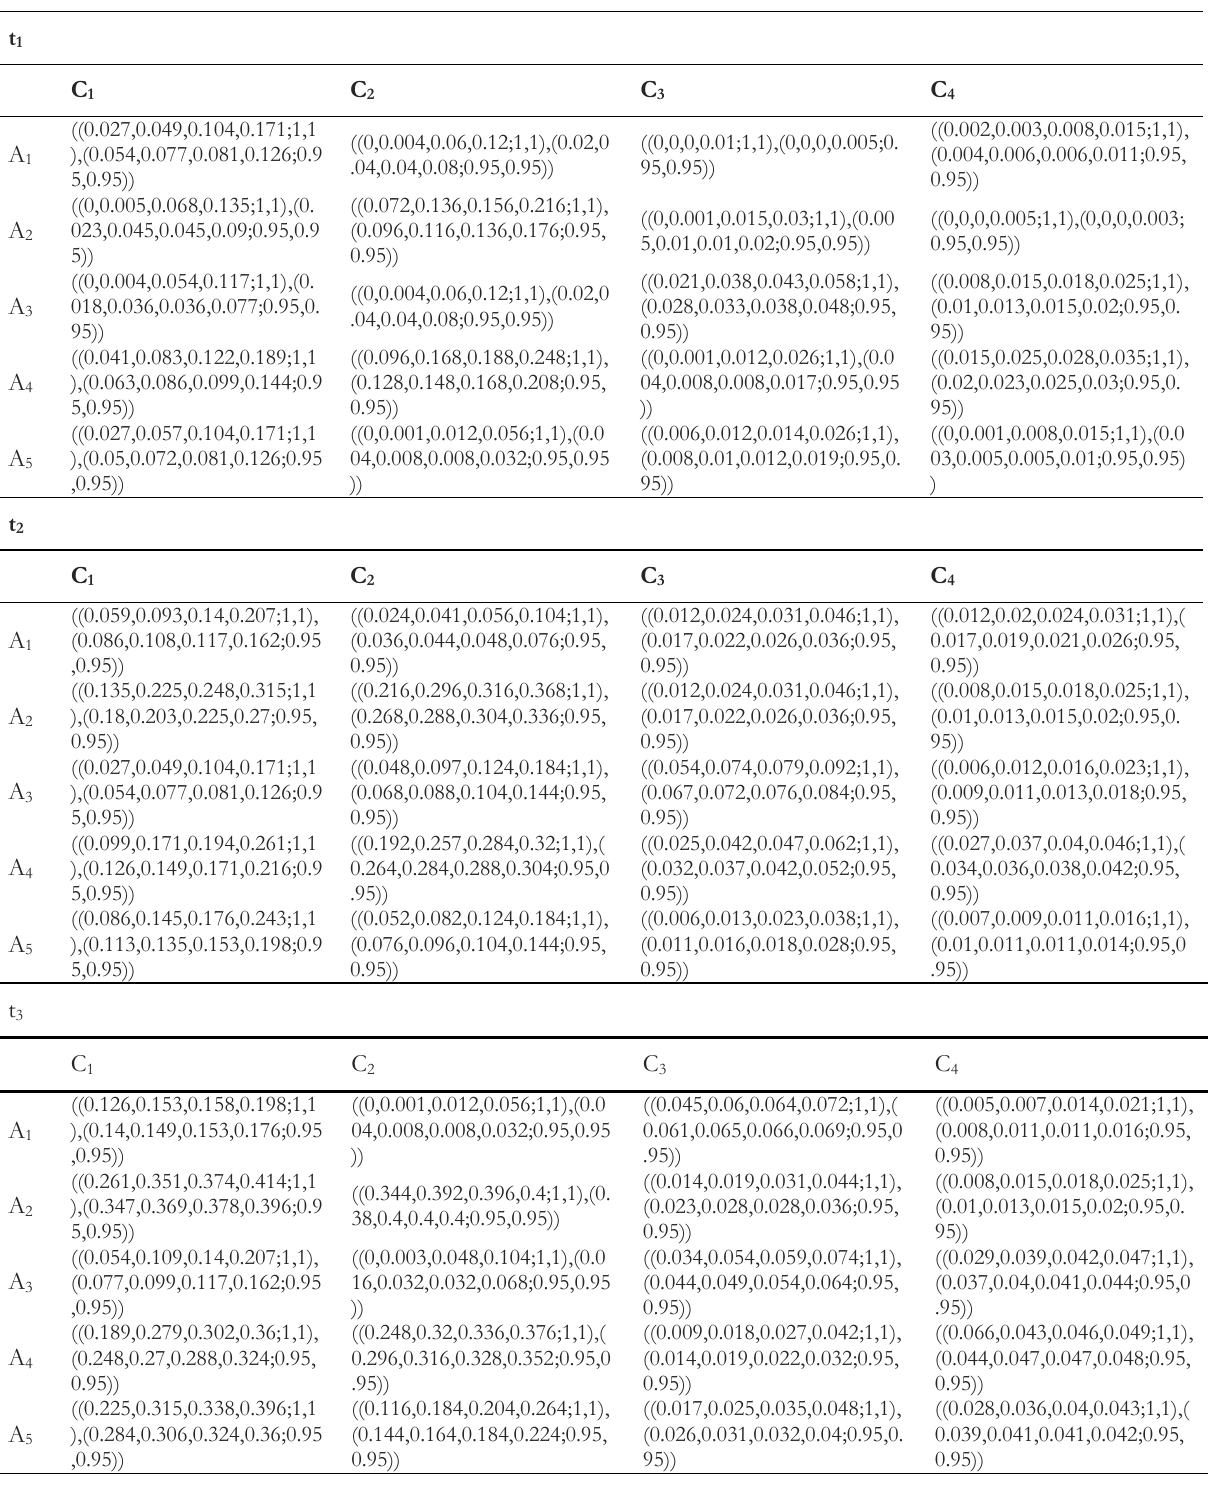
Table 4. Weighted decision matrix in three periods of